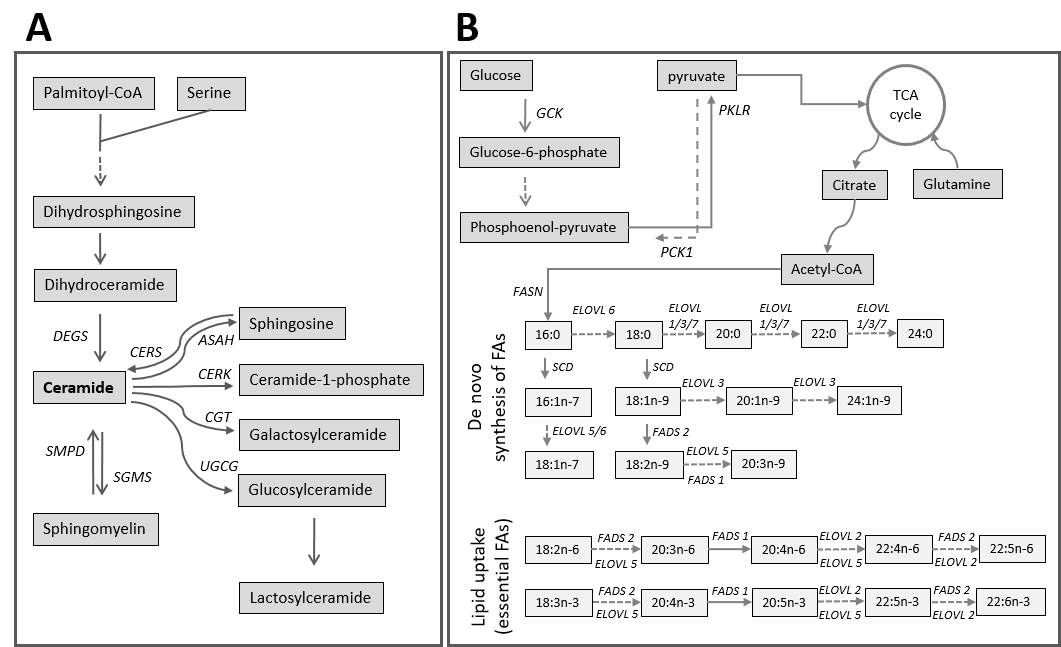
Figure 4. ( A ) Demonstrates a simplified pathway of sphingolipids (SLs) together with the